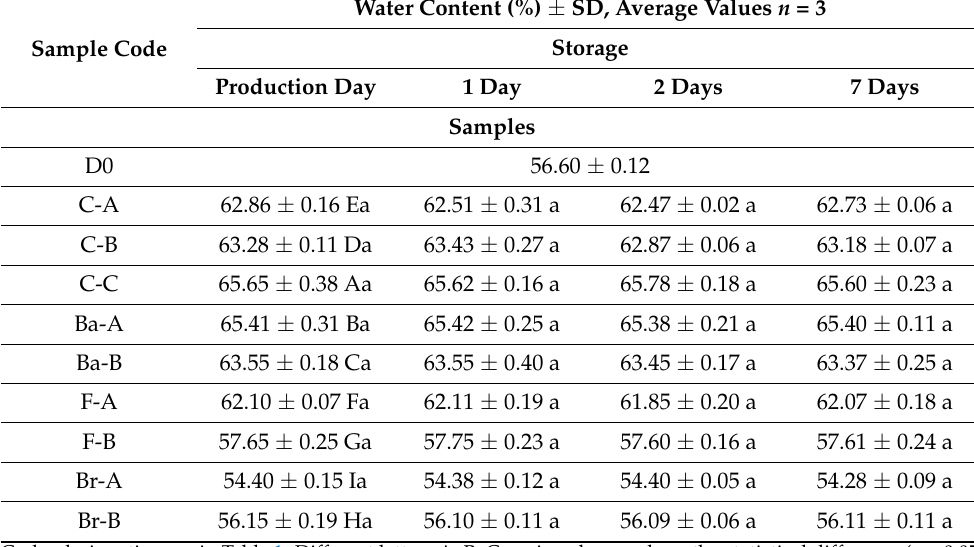
Table 4. Water content in chicken breast